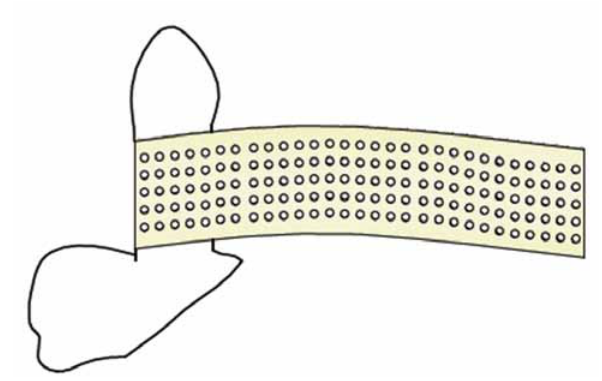
Figure 4 - Schematic drawing of the application of the biopolymer pellicle of